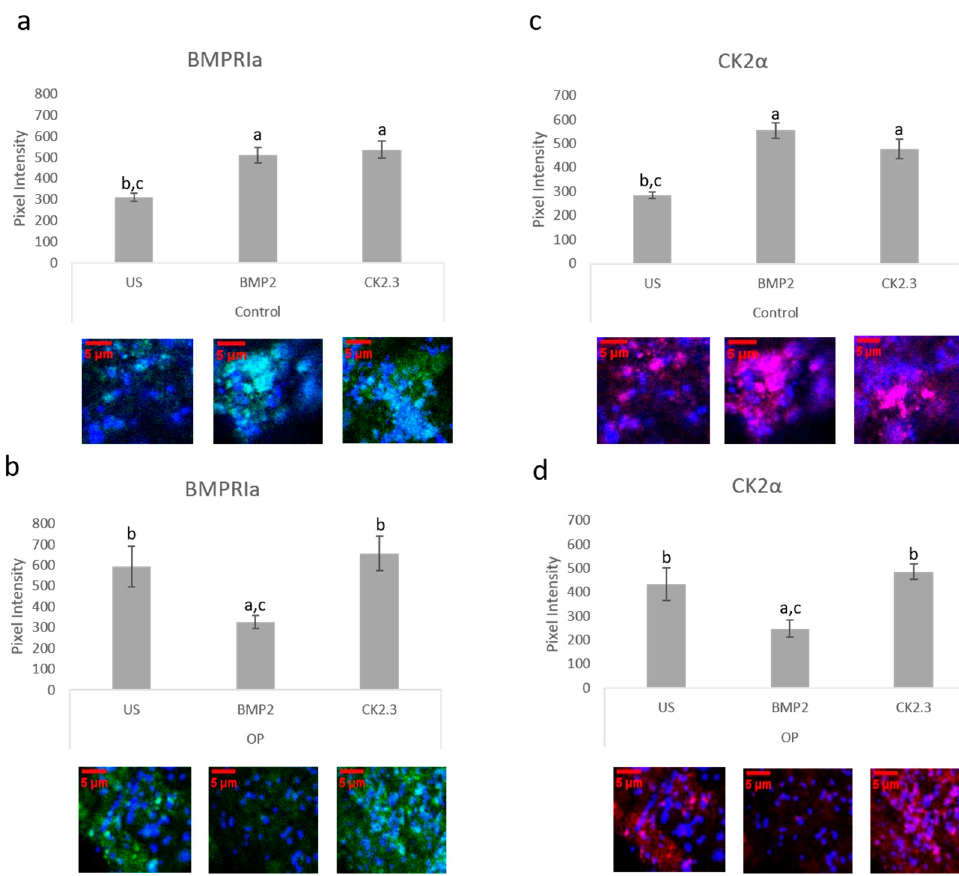
Figure 6. Trabecular bone slices were removed from isolated femoral heads. OP and control explants were prepared as previously described. Fixed explants were stained fluorescently for BMPRIa (green), CK2 α (red), and the nucleus (blue). ( a ) In control explants CK2.3 and BMP2 significantly increased BMPRIa expression when compared to US explants. ( b ) In OP explants, BMP2 significantly decreased BMPRIa expression when compared to CK2.3 and US explants. ( c ) In control explants, BMP2 and CK2.3 significantly increased expression of CK2 α when compared to US explants. ( d ) In OP explants, BMP2 stimulation significantly decreased expression of CK2 α when compared to US and CK2.3 stimulated explants. Error bars represent standard error of the mean (SEM). “a” denotes statistically significant to US explants, “b” denotes statistically significant to BMP2 stimulated explants, and “c” denotes statistically significant to CK2.3 stimulated explants ( p < 0.05).